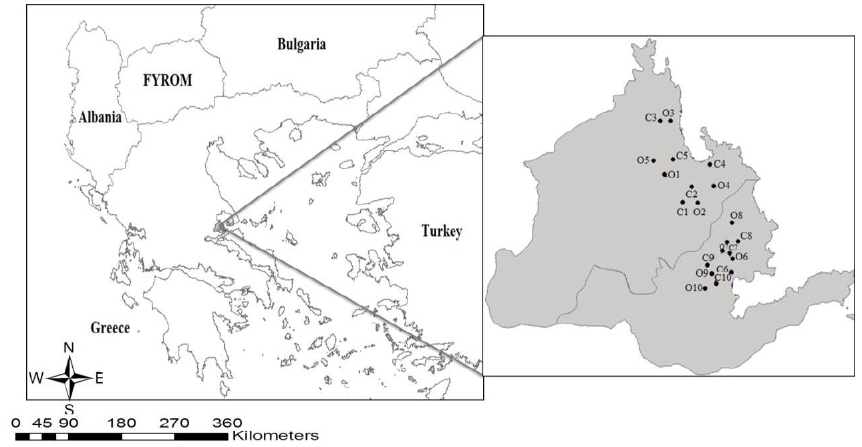
Figure 1. Study area.